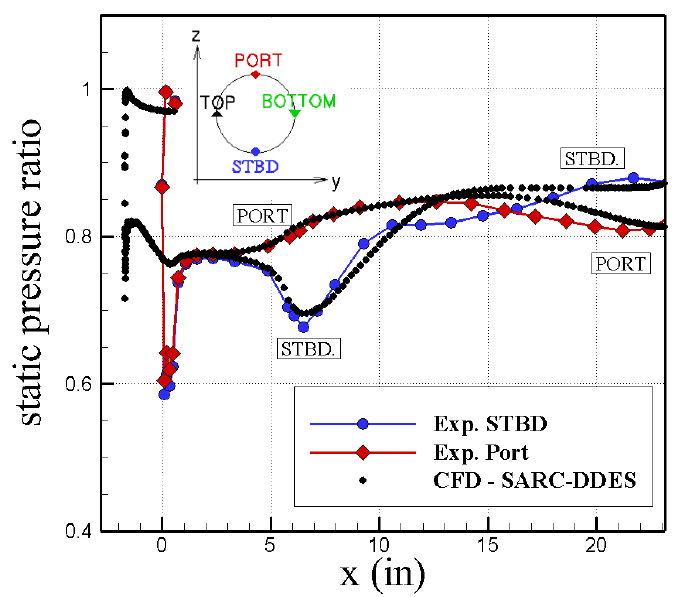
Figure 8. M2129 DP78 wall pressure measurements and simulations using Kestrel and SARC–DDES turbulence model. Static pressure ratio, p f / p 0 ∞ , is the ratio of averaged engine face static pressure to free-stream total pressure. NASA baseline grid was used. CFD data are time-averaged from 2 to 2.5 s of simulation time.